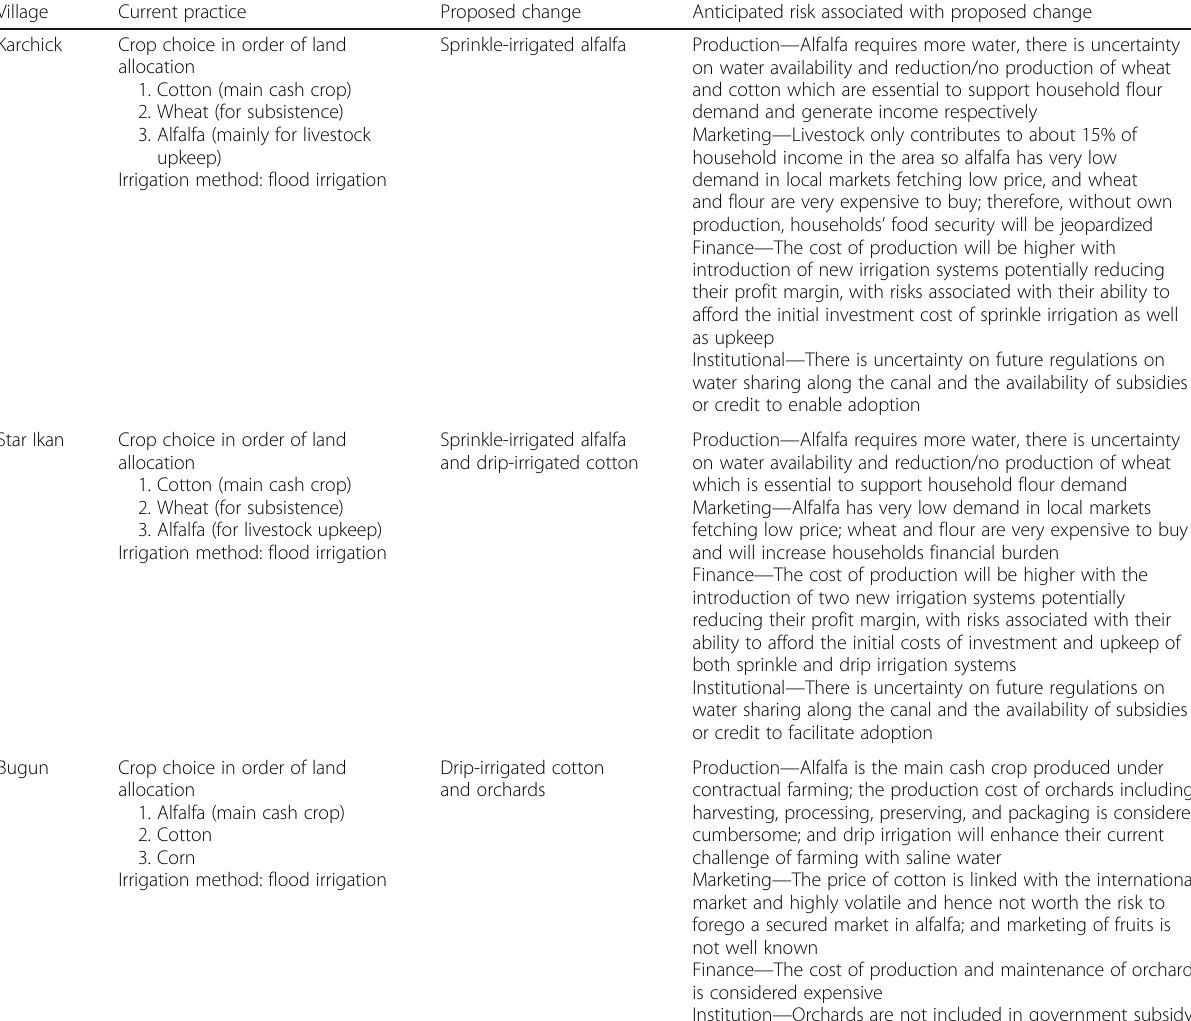
Table 5 Risk analysis — summary